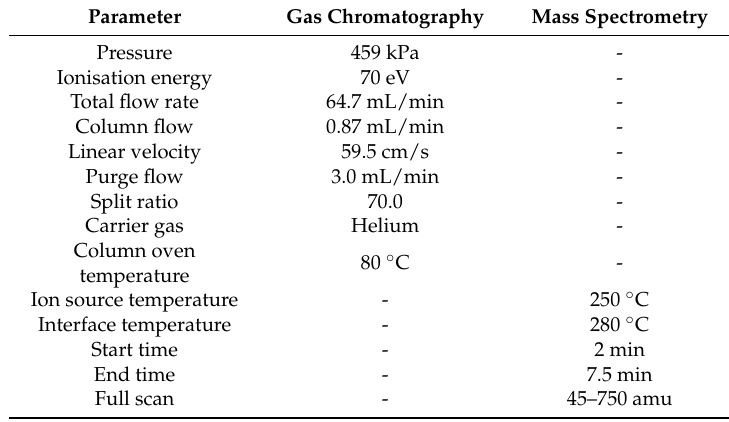
Table 1. GCMS operating conditions (instrument: Shimadzu GCMS-QP